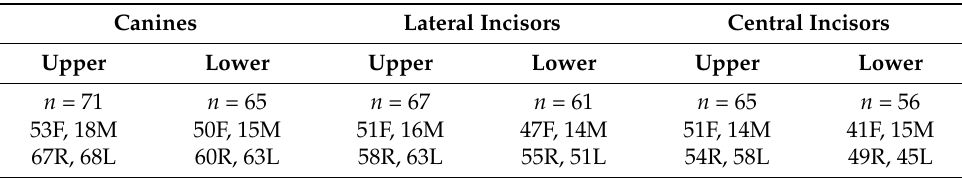
Table 1. Teeth that comprised the tooth wear measurement sample.